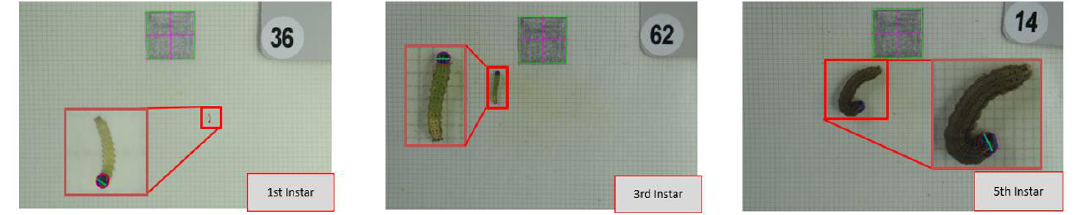
Figure 7. Example of calculating head capsule width.